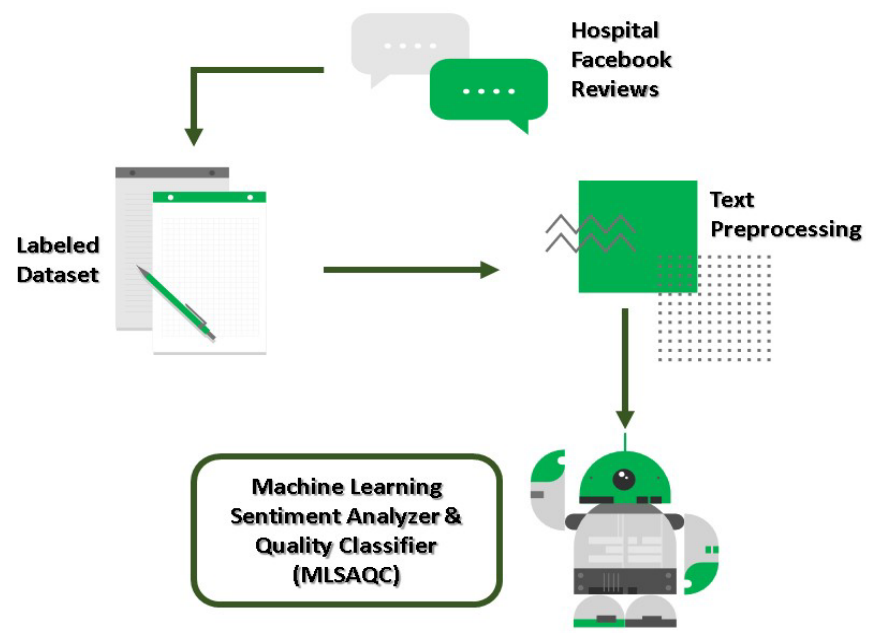
Figure 1. Machine Learning Development